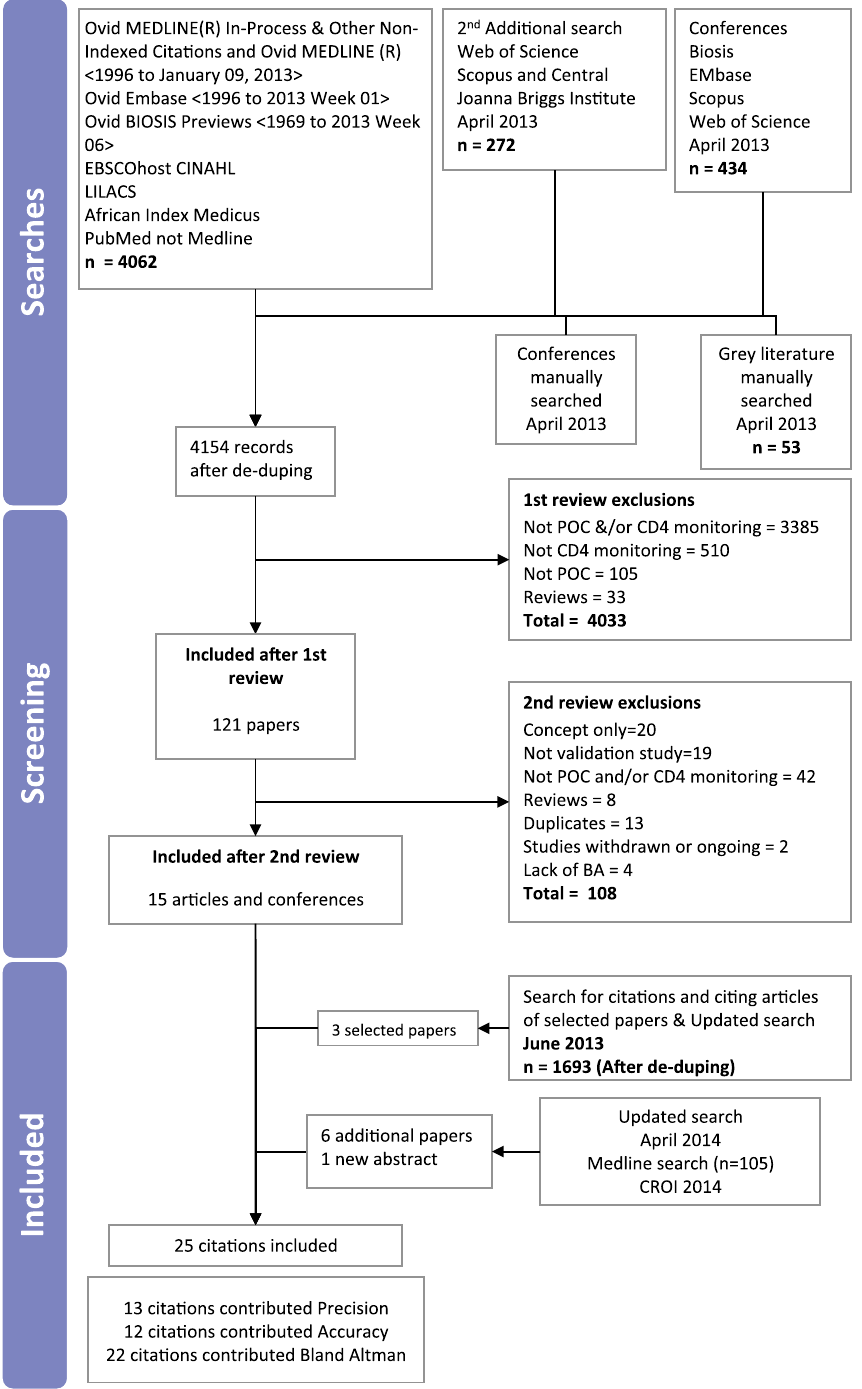
Figure 1. Flow diagram of study agreement between two continuous measures and more